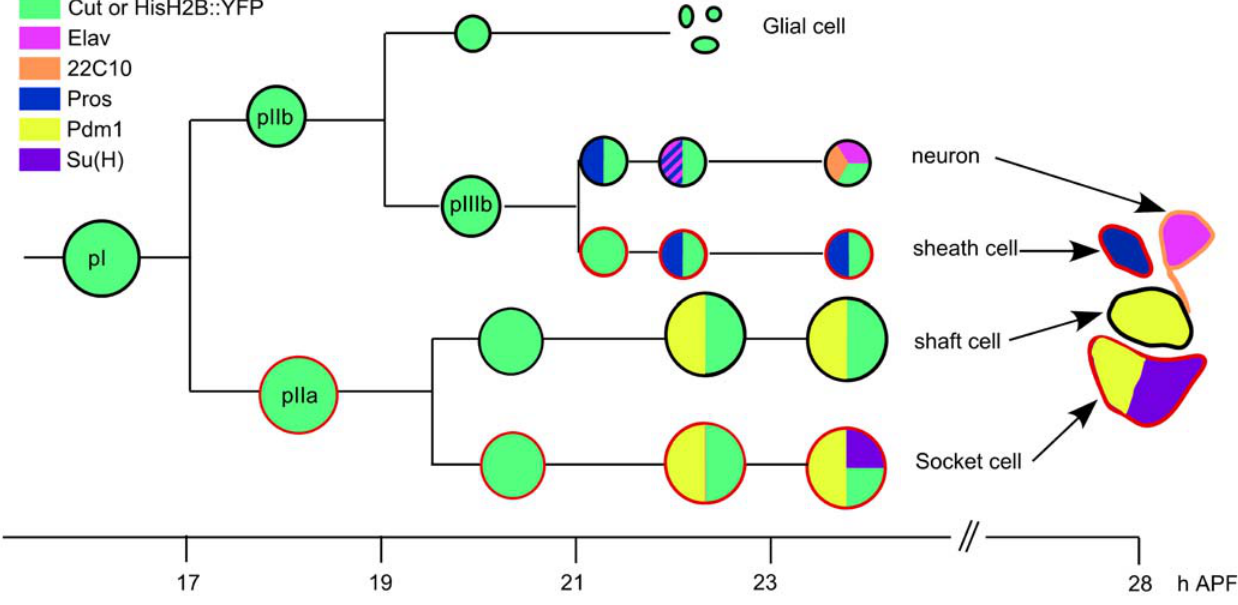
Figure 1. Schematic representation of the wild type bristle lineage and cell markers used. Cells are represented by circles showing the relative nuclear size with the expression of five molecular markers indicated in colour. On the right, a sensory organ conserving the relative position of each cell, anterior is on the top. Cells encircled in red are N-on cells and other the N-off cells. All cells are identified by Cut immunoreactivity or after neur . HisH2B::YFP overexpression (green). Markers: Prospero (Pros) in blue; ELAV in pink; 22C10/Futsch in orange; Pdm1 in yellow and Suppressor of Hairless (Su(H)) in purple. Time (h) APF is indicated at the bottom.